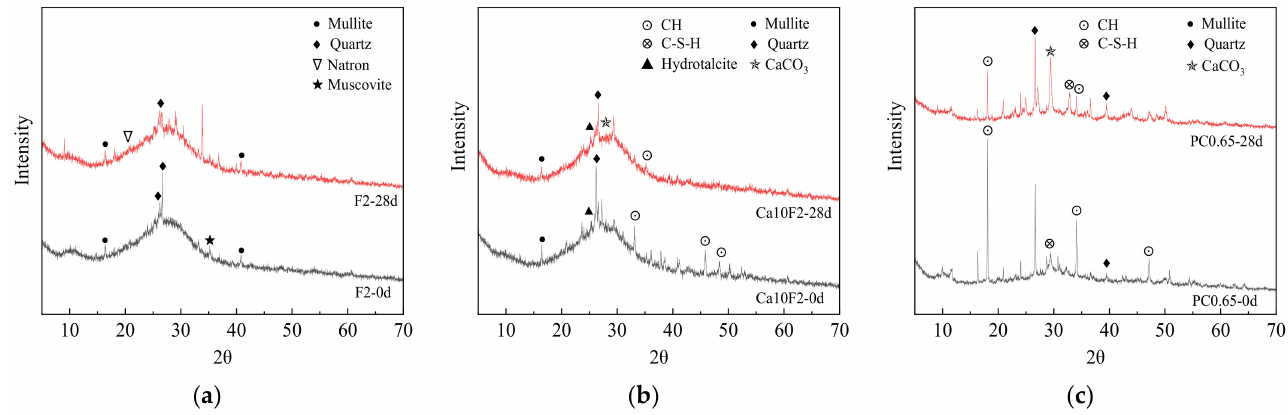
Figure 8. XRD patterns of geopolymers and cement before and after carbonization. ( a ) F2; ( b ) Ca10F2; ( c )